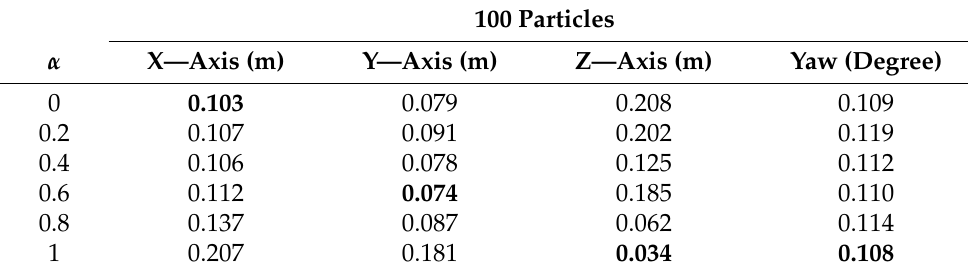
Table 2. RMS errors with different values of α using 100 particles.